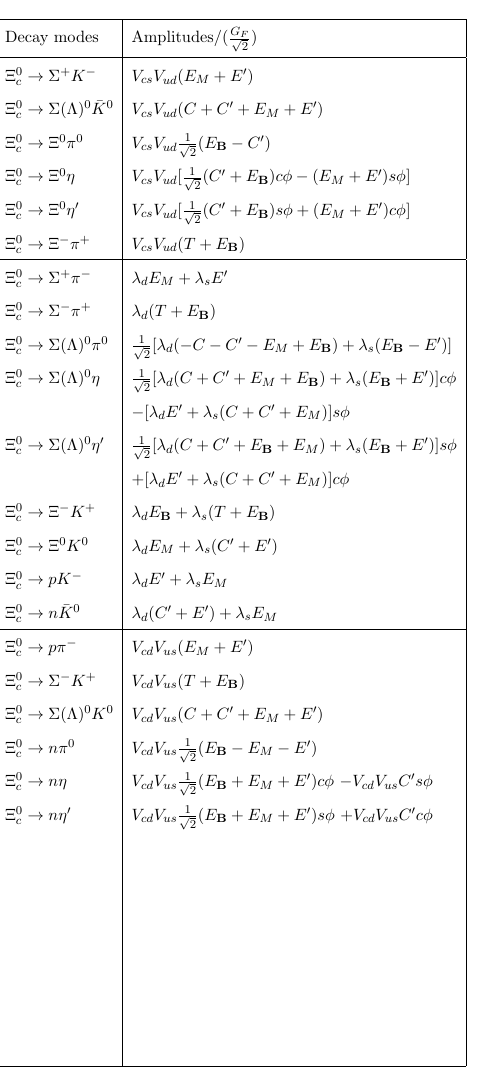
Table 1 . Amplitudes of B c for the (cid:17) - (cid:17) 0 mixing. and the newly observed the CKM matrix elements in the Wolfenstein parameterization, given by